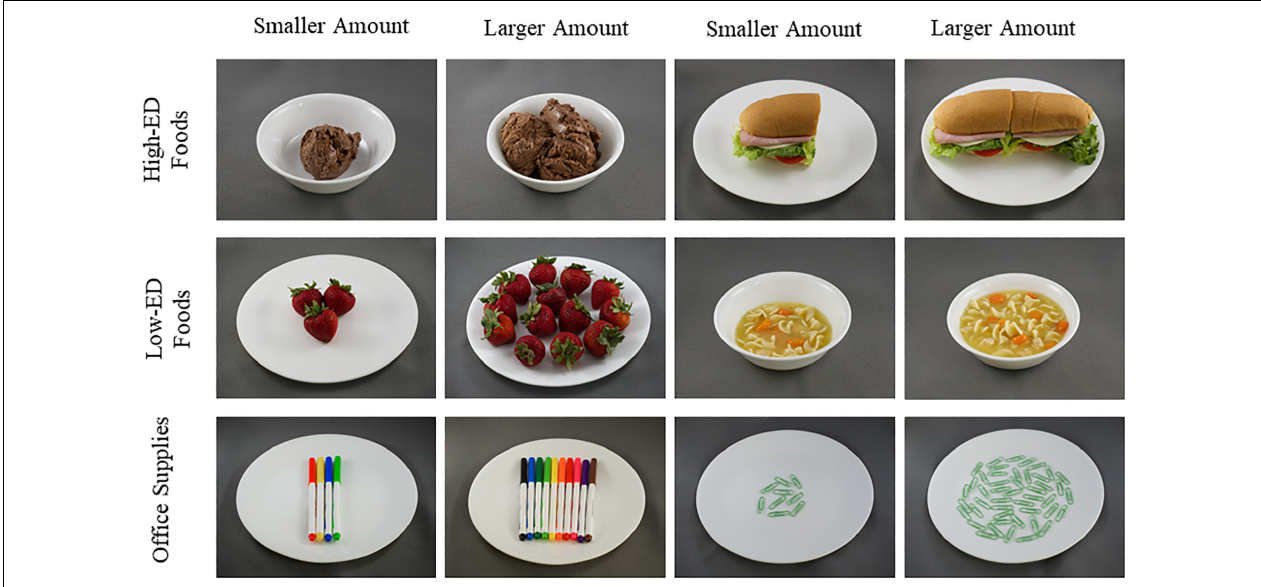
FIGURE 2 | Example images of smaller and larger amounts of high-energy-dense foods. low-energy-dense foods and office supplies from a standardized image set developed investigate the cognitive and neurobiological mechanisms of eating behaviors in 6- to 10-year-old children.